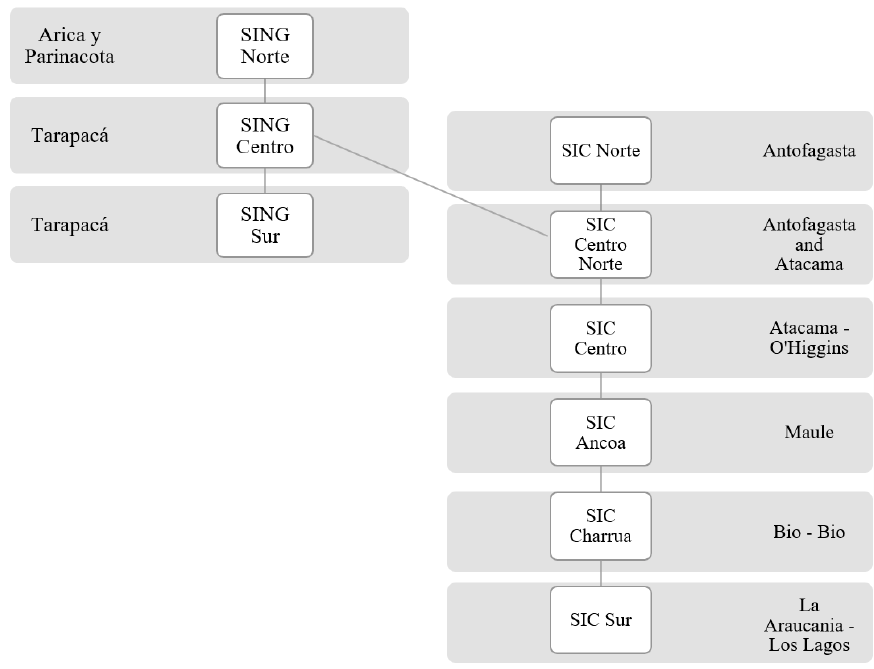
Figure 2. Diagram of transmission lines and representative nodes. Table 1. Electricity demands obtained from (PELP [21]—scenario C)